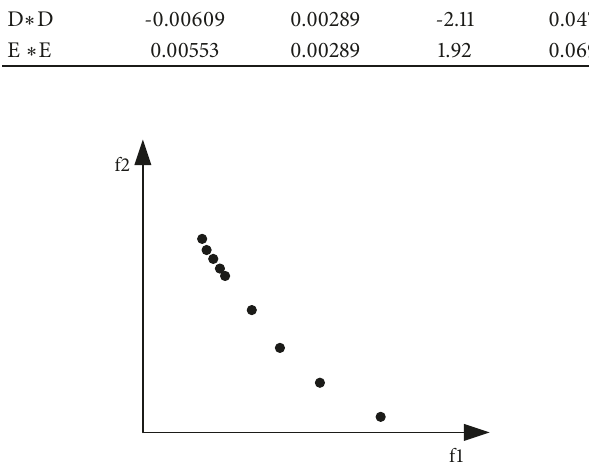
Figure 17: Crowding